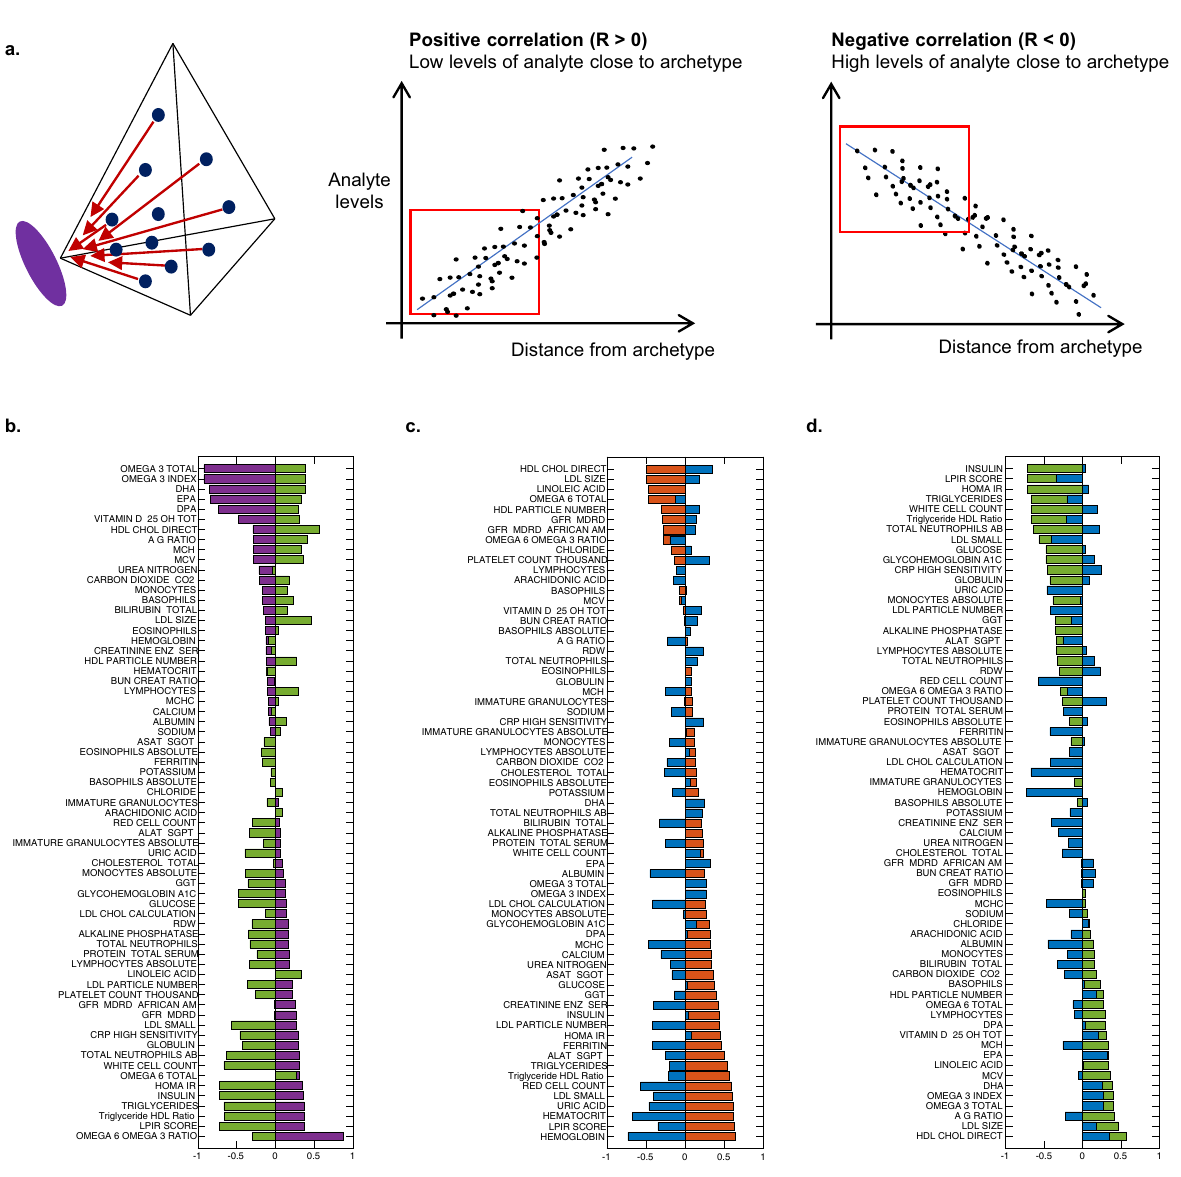
Fig. 4 Correlations between the distances from the archetypes and analyte levels reveal the principal analytes next to every archetype, and the trade- offs in the data. a Schematic view: the distances between the data-points and the archetypes were correlated with the levels of each analyte. Positive correlation ( R > 0) means that low levels of the analyte correlate with shorter distance from the archetype, negative correlation ( R < 0) means that higher levels of the analyte correlate with shorter distances from the archetype. b The correlation coef fi cients of analyte levels with distance from Archetype I were ordered and presented in the horizontal bar plot (purple), and compared to the correlation coef fi cients of the analytes with distances from Archetype IV (green bars). c The same as b for Archetype II (orange bars) and Archetype III (blue bars), analytes were ordered according to the correlation coef fi cients of Archetype II. d The same as b for Archetype IV (green bars) and Archetype III (blue bars), analytes were ordered according to the correlation coef fi cients of Archetype IV. The full table of the correlation coef fi cients can be found in Supplementary Figs. 5 –